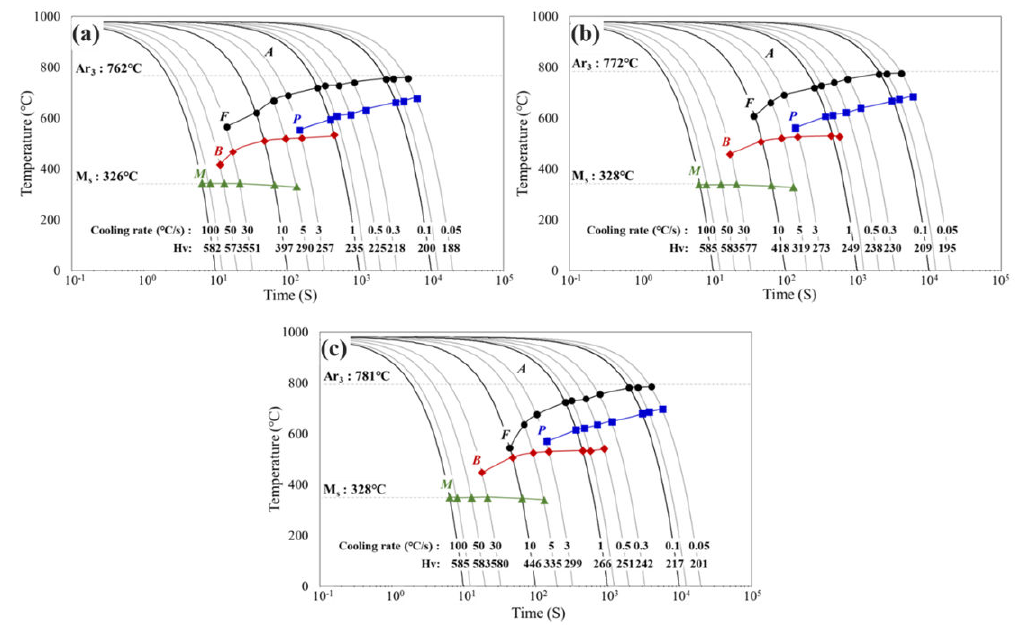
Figure 2. CCT diagrams drawn for various V contents: ( a ) RB V0, ( b ) RB V1, ( c ) RB V2. A − austenite, F − ferrite, P − pearlite, B − bainite and M −